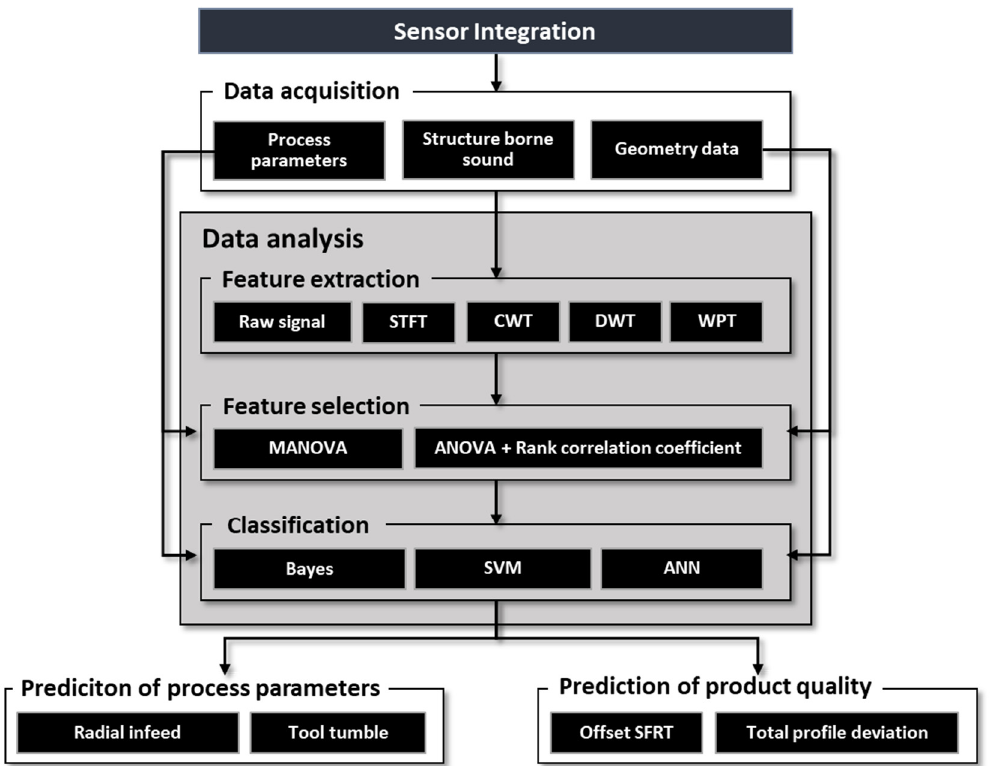
Figure 6. Classification data pipleine.